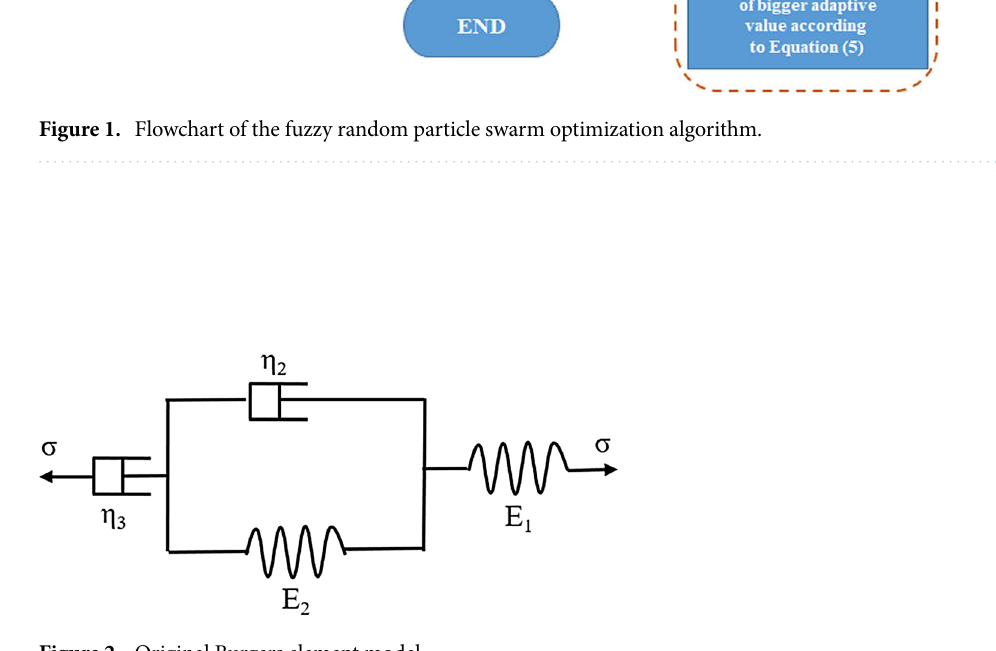
Figure 2. Original Burgers element